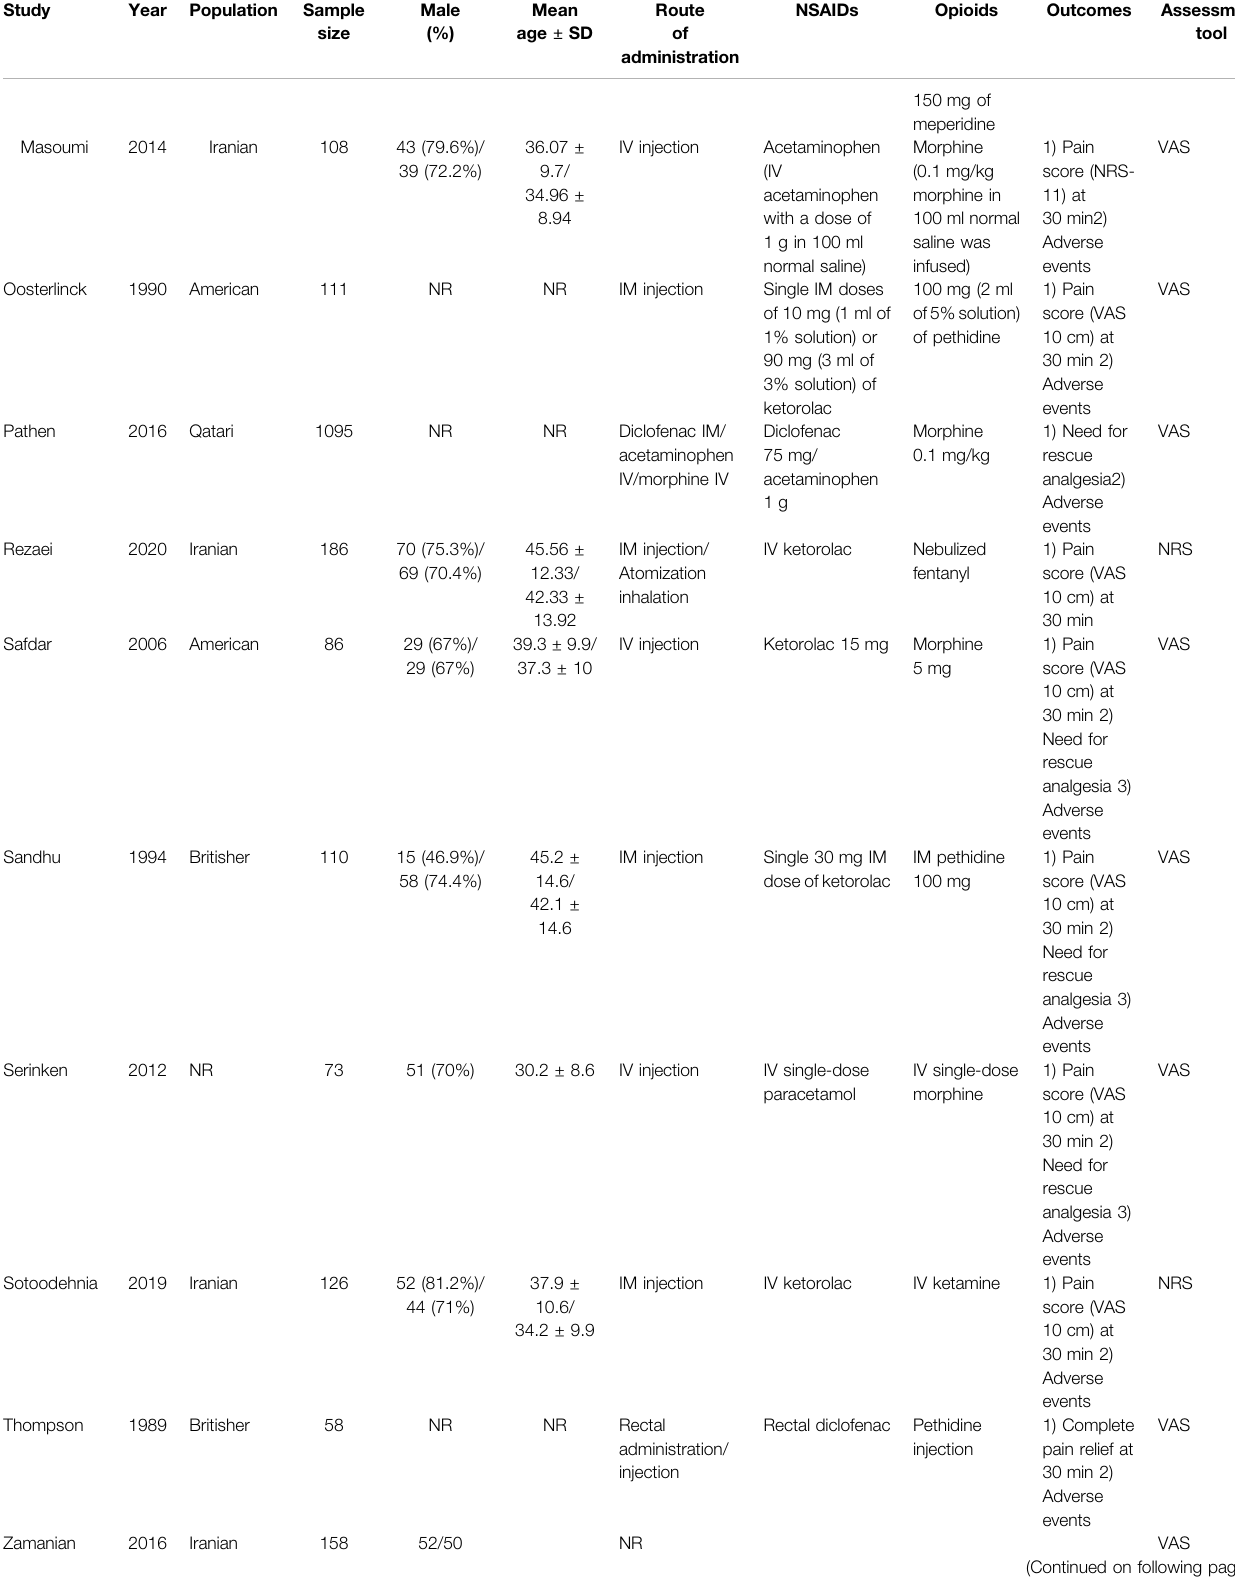
TABLE 1 | ( Continued ) Summary of included clinical trials and patient